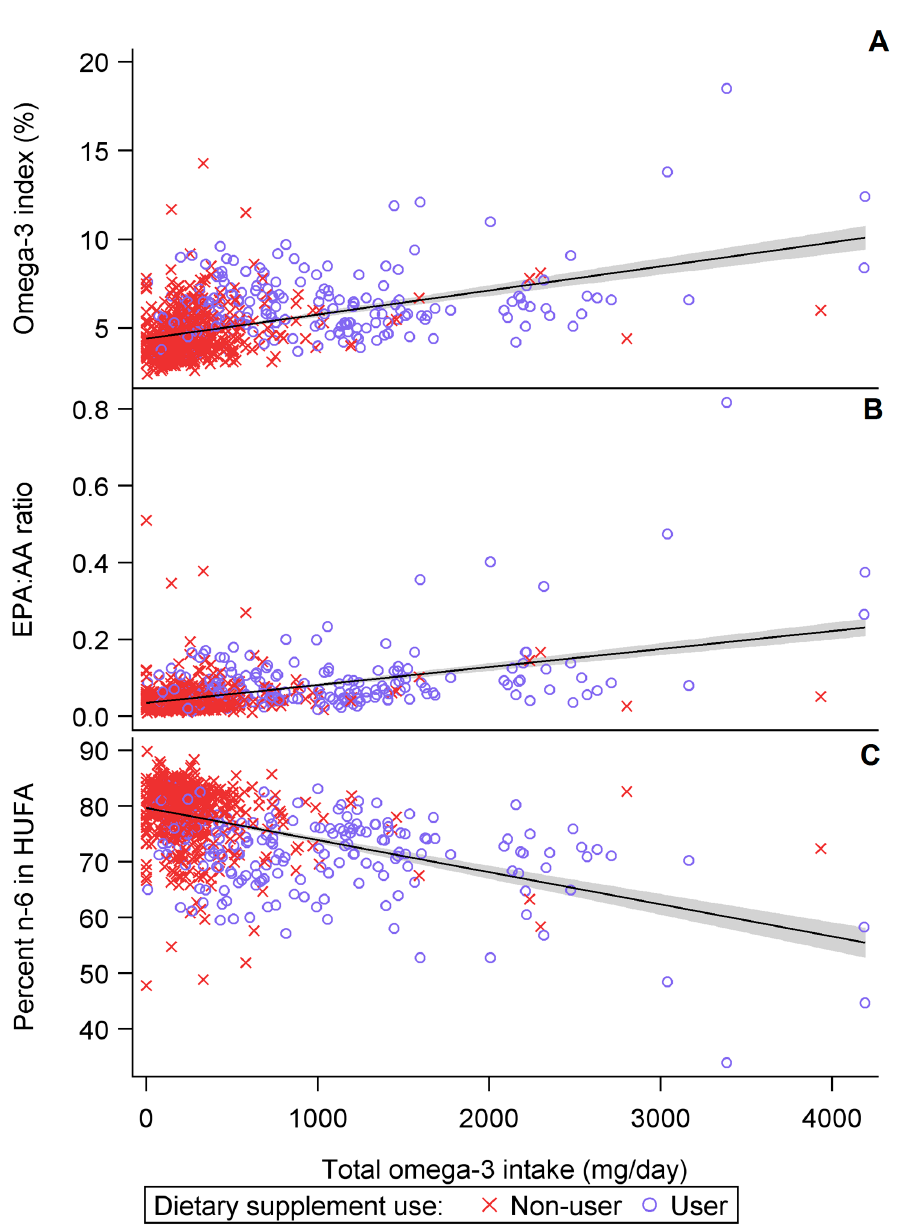
Figure 2. Blood fatty acid measures versus omega-3 intake by omega-3 supplement use at baseline ( n = 834) for ( A ) omega-3 index or ( B ) EPA:AA ratio or ( C ) percent n6 in HUFA.